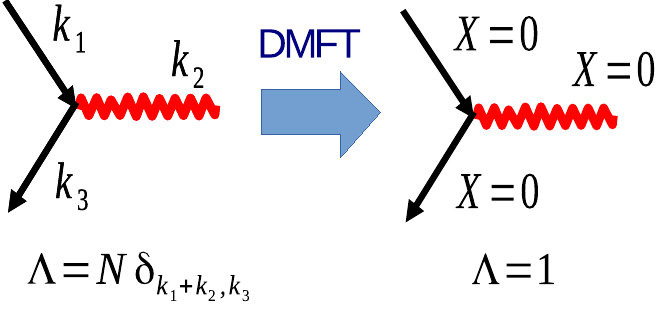
Figure 14. The Laue function Λ , which described momentum conservation at a vertex (left) with two Green’s function solid lines and a wiggly line denoting an interaction (perhaps mediated by a Boson). In the DMFT/CPA we take Λ = 1, so momentum conservation is neglected for irreducible graphs (right) so that we may freely sum over the momentum labels ˜k , ˜k (cid:48) leaving only local ( X = 0) propagators · · · and interactions.